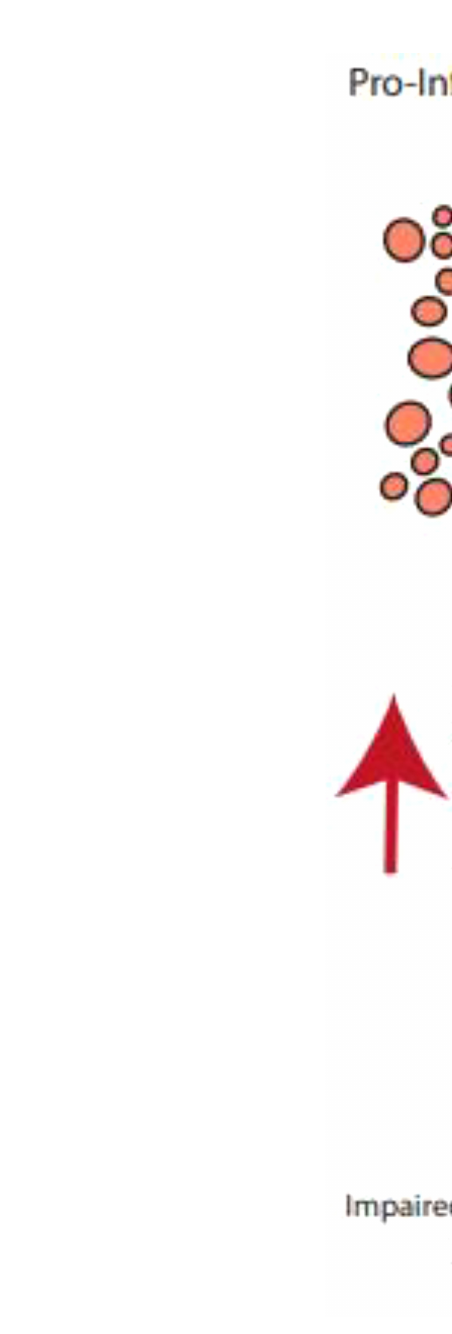
FIGURE 3 Pro-in fl ammatory cytokines upregulated by ICI therapies may activate certain T cell subsets, leading to a constellation of non-speci fi c in fl ammatory processes known as the cytokine release